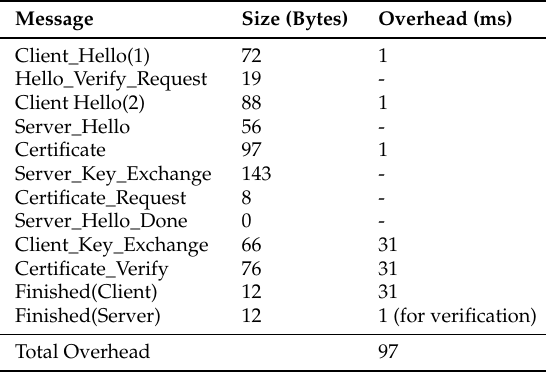
Table 7. DTLS-ECC packet size and overheads.